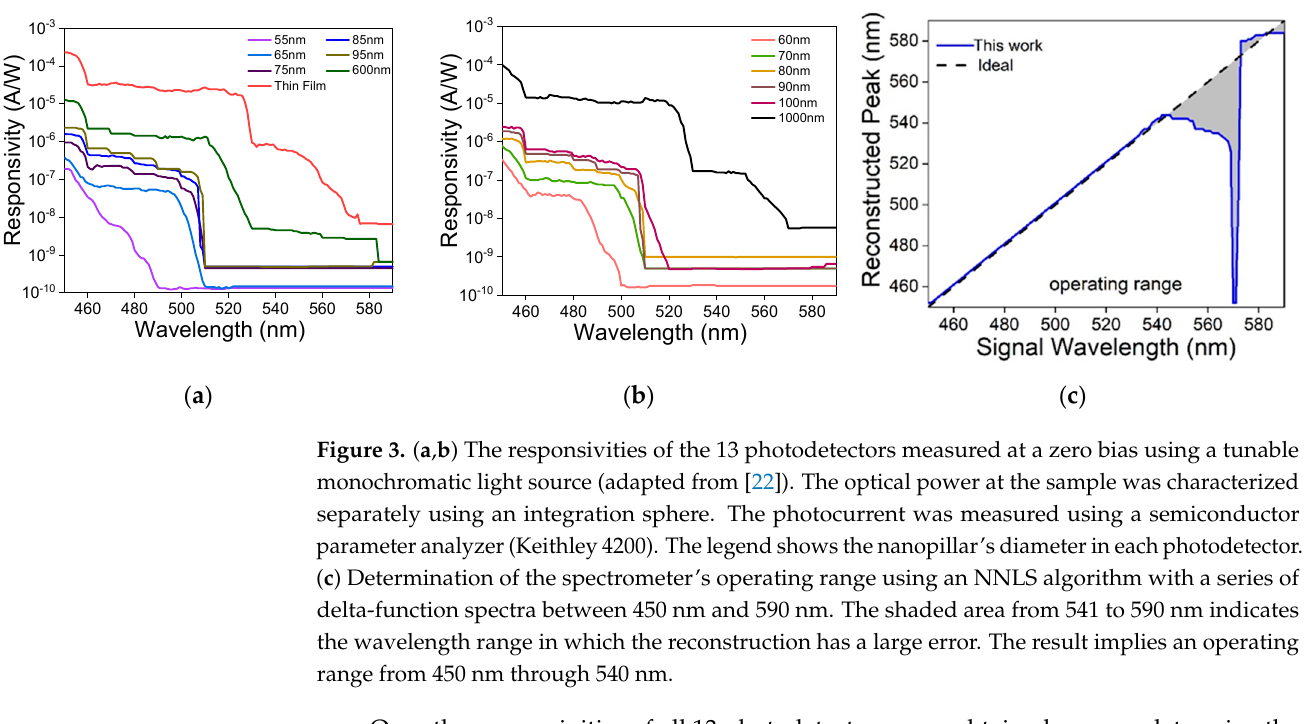
Figure 4. ( a ) The experimental configuration to demonstrate the feasibility of the monolithically in ‐ tegrated LED light source in reflection spectroscopy. A notch filter was used to modify the LED emission. Together with the mirror, the reflected spectrum simulated an analyte absorbing around 533 nm with an absorption linewidth of 17 nm. The distance between the mirror and the chip is 4 cm. No other optics other than the two shown were used. ( b ) The LED emission (green dotted